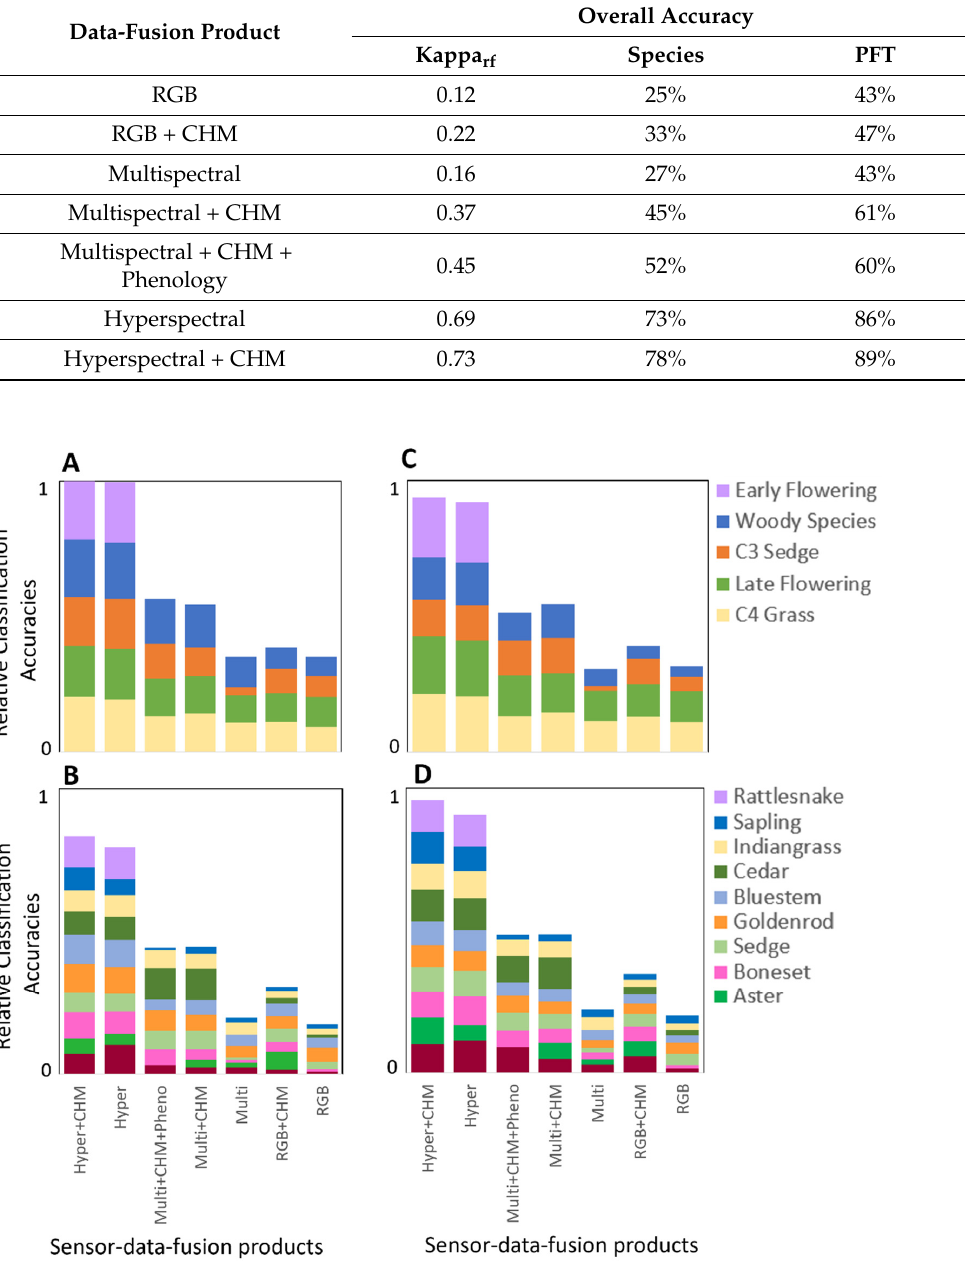
Figure 8. User and producer accuracy results for each sensor-fusion product for plant species and PFTs computed by confusion matrices (available in Supplementary Materials). ( A ) Producer accuracy for PFTs, ( B ) producer accuracy for species, ( C ) user accuracy for PFTs, and ( D ) user accuracy for